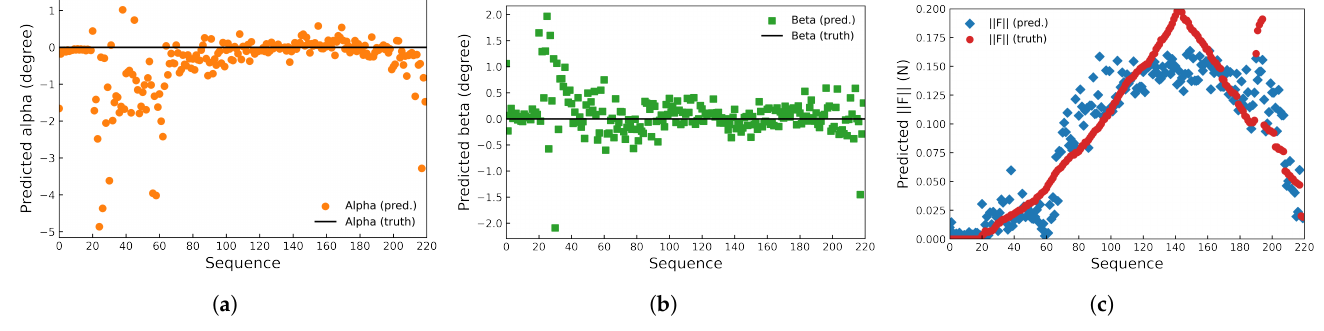
Figure 11. Predicted ( a ) α , ( b ) β , and ( c ) (cid:107) F (cid:107) at pose α = 0 ◦ , β = 0 ◦